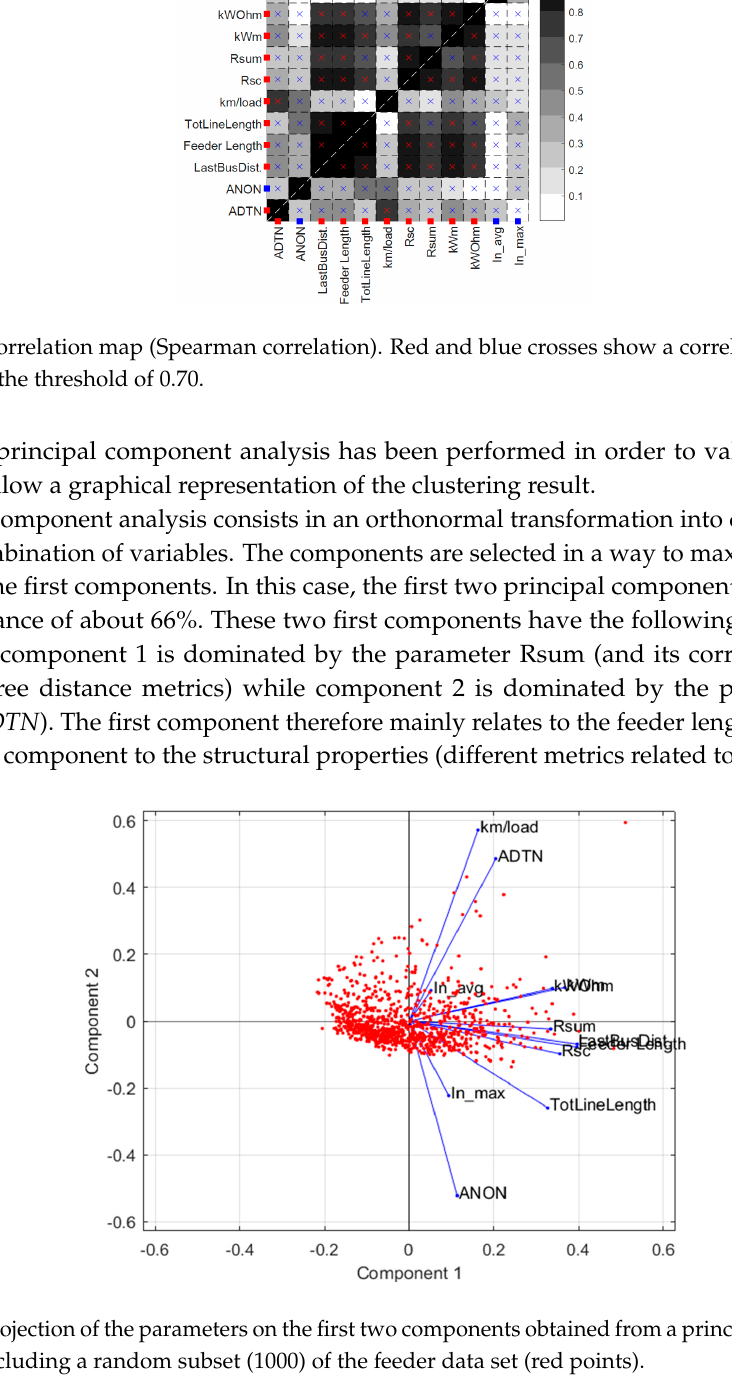
Figure 4. Projection of the parameters on the first two components obtained from a principal component analysis, including a random subset (1000) of the feeder data set (red points).